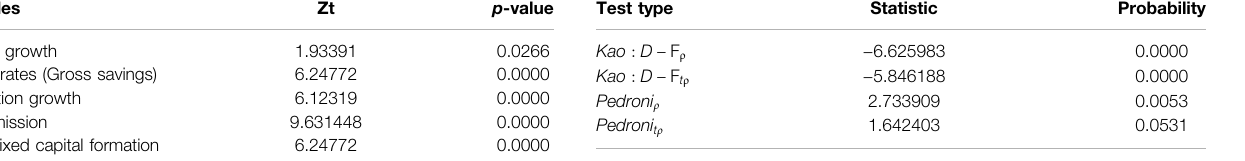
TABLE 5 | Panel data stationarity test estimates — Hadri and Larson. Variables Zt